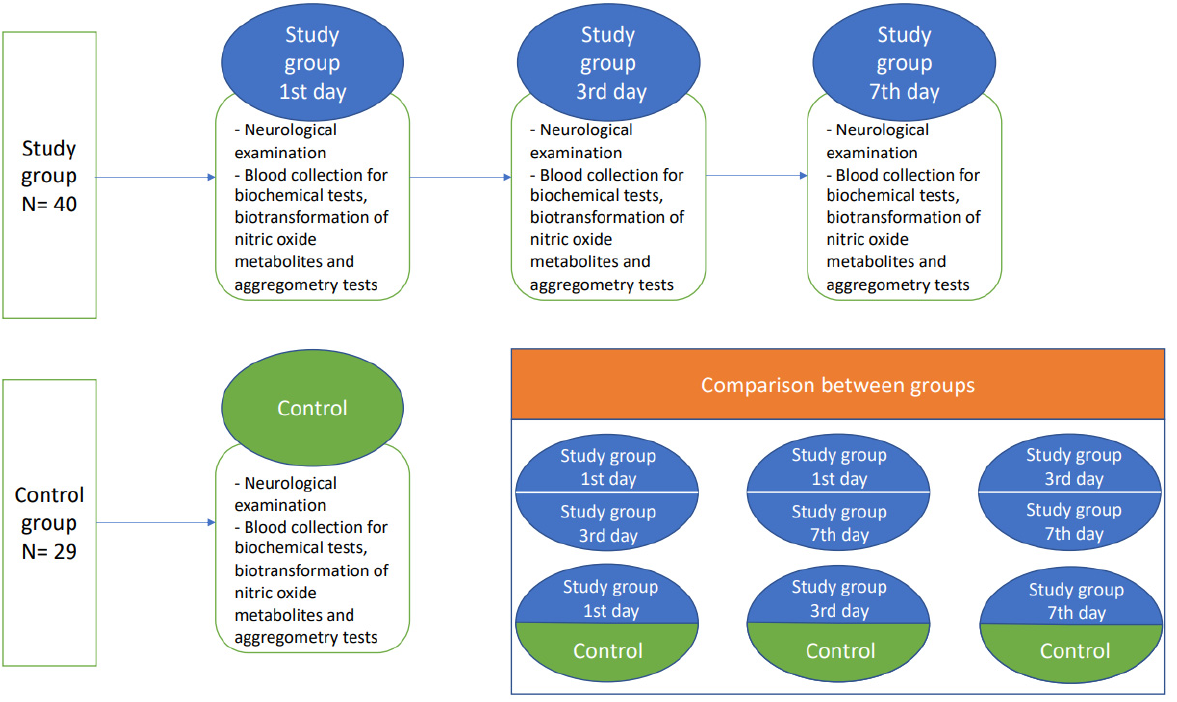
Figure 3. A flow chart of the study protocol.